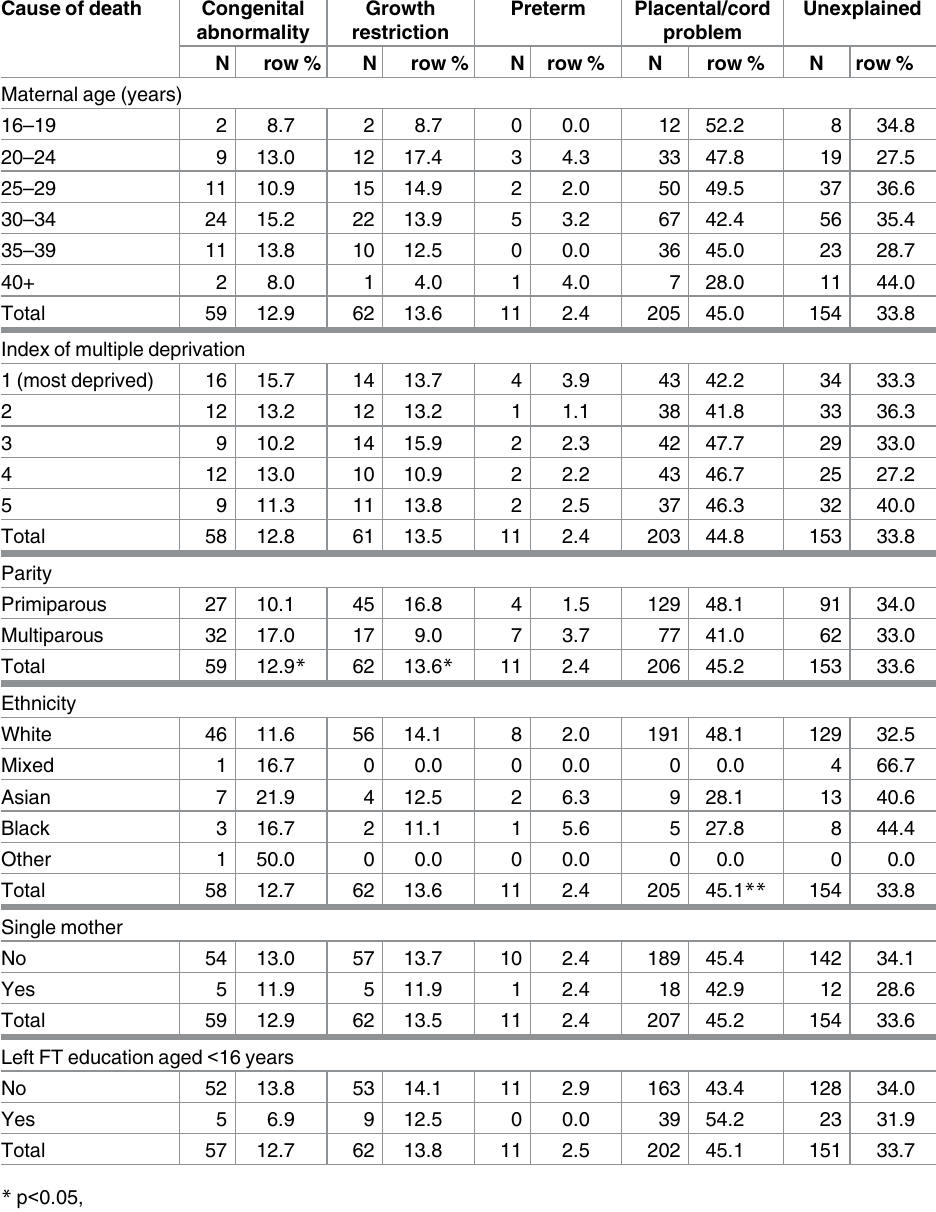
Table 7. Parental understanding of cause of